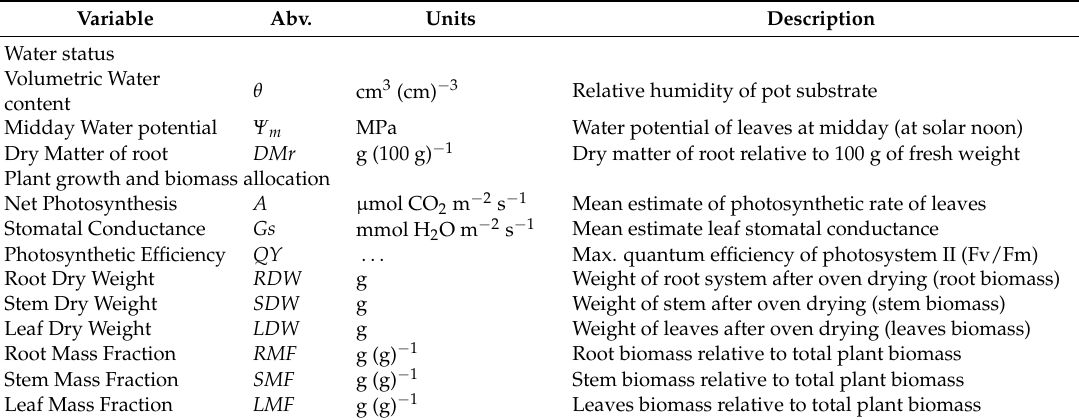
Table 1. Description of studied